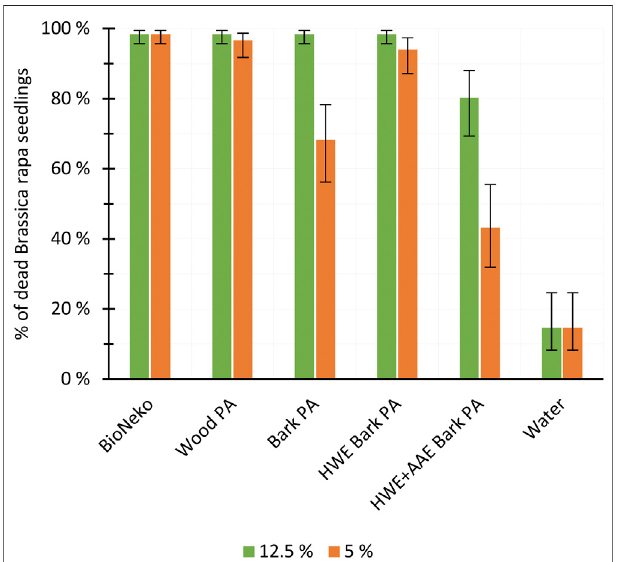
FIGURE 9 | Fungal coverage area (in square millimeters) at 2, 4, and 7 days after treating the growth media with pyrolysis acids produced from wood, bark, hot water-extracted (HWE) bark, or HWE+alkaline alcohol- extracted (AAE) bark (mean ± SD, n =